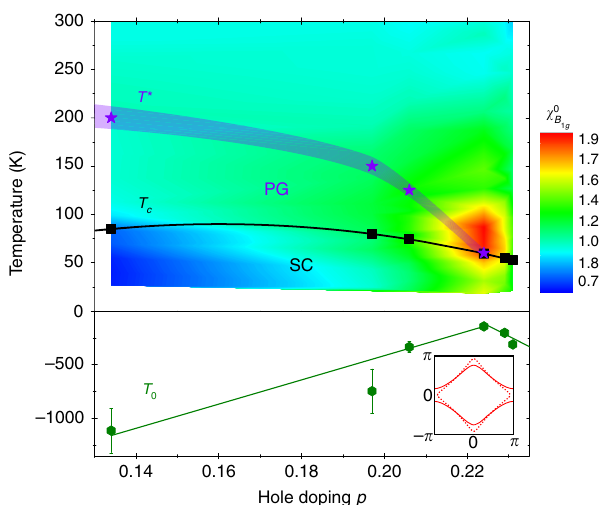
Fig. 3 Phase diagram of critical nematic fl uctuations. Color-coded plot summarizing the evolution of the B 1 g nematic susceptibility as a function of doping and temperature in Bi2212. The nematic Curie-Weiss temperature T 0 is also shown along with the superconducting T c and pseudogap T (cid:2) temperatures. The lines are guide to the eye. The error bars for T 0 correspond to the standard error of the Curie-Weiss fi ts. The inset shows the Fermi surface deformation associated to the incipient Pomeranchuk instability which breaks the C 4